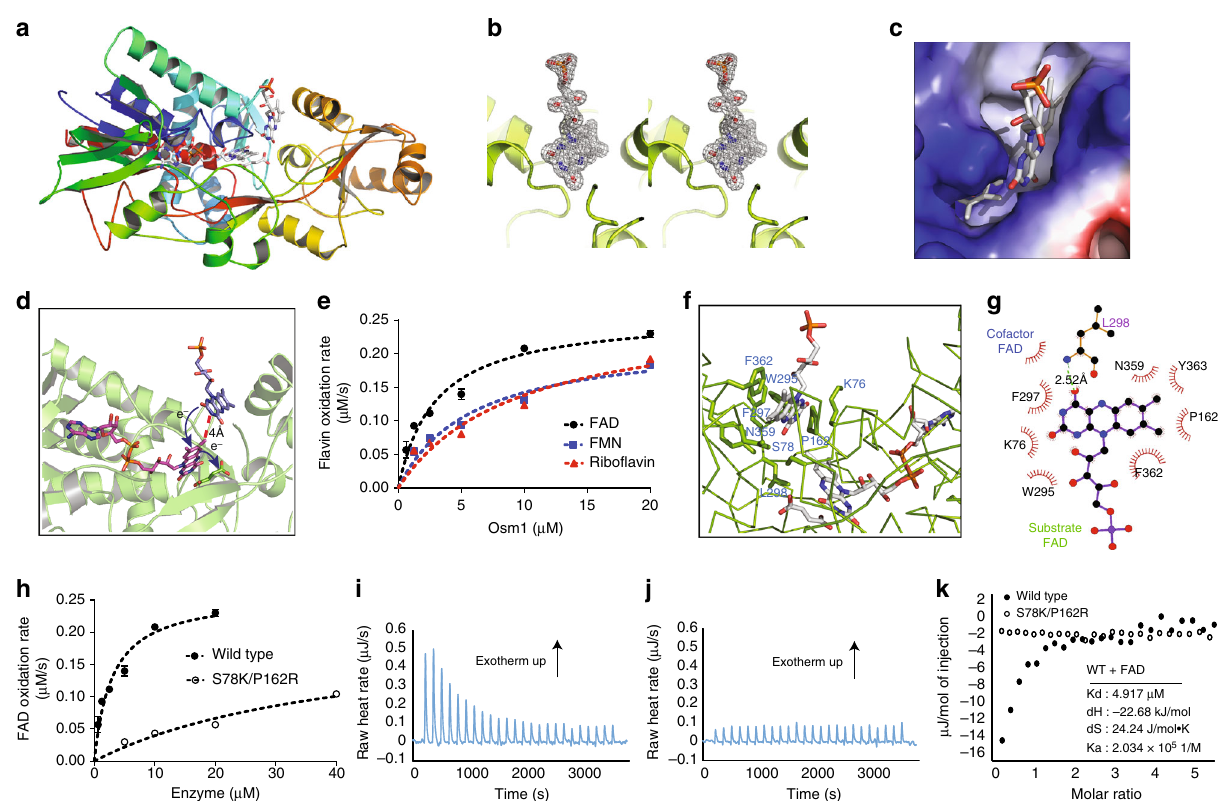
Fig. 3 Osm1 crystal structure revealing the second FAD-binding pocket. a Ribbon diagram of the structure of a second FAD bound to Osm1. The chain from the N- to C-termini is colored blue to red. b A stereo image of an omit density map contoured at the 1 − σ level around the second FAD-binding site. c Electrostatic surface in the second FAD-binding pocket. d Active site of Osm1 including a second FAD-binding site. A model of the second FAD-mediated electron transfer from the second FAD to substrate (fumarate) via the FAD cofactor ( fi rst FAD) is indicated. e All of the reduced FAD, FMN, or ribo fl avin (50 µ M) were re-oxidized by Osm1 in the presence of fumarate. f Details of the environment of the second FAD-binding site. The residues involved in the FAD interaction are indicated. g A 2D diagram of the interaction between the second FAD and Osm1. The residues involved in the second FAD interaction are indicated. h WT Osm1 (closed circle) and S78K/P162R mutant (open circle) were incubated with reduced free FAD in the presence of fumarate. The mutant Osm1 oxidized FAD more slowly than WT Osm1. i , j Free FAD binding to WT Osm1 ( i ) and S78K/P162R ( j ) were analyzed by ITC. k The integrated heat area of WT Osm1 (closed circle) and mutant (open circle) were plotted by FAD-to-Osm1 molar ratio, calculating the binding af fi nity between WT Osm1 and free FAD. The experiments for calculating catalytic reaction rates were performed three times for e , h , and error bars were derived by standard